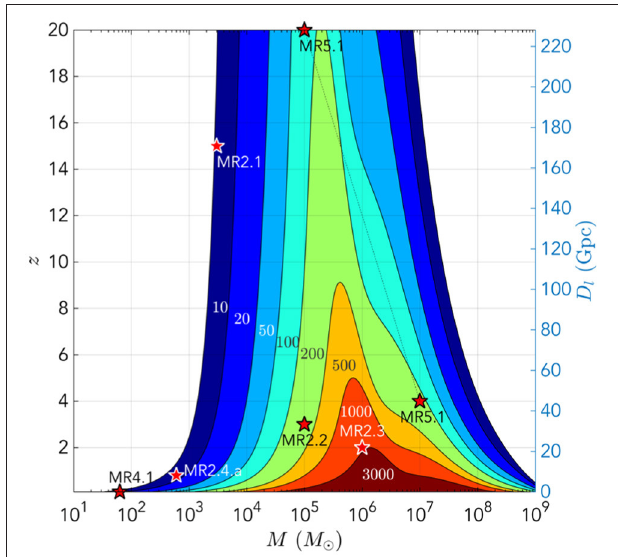
FIGURE 2 | S/N levels as a function or redshift (left scale) and luminosity distance (right scale) and of total source frame mass for the baseline configuration of LISA, for a fixed mass ratio of q threshold cases to define mission requirements. From Danzmannet al.